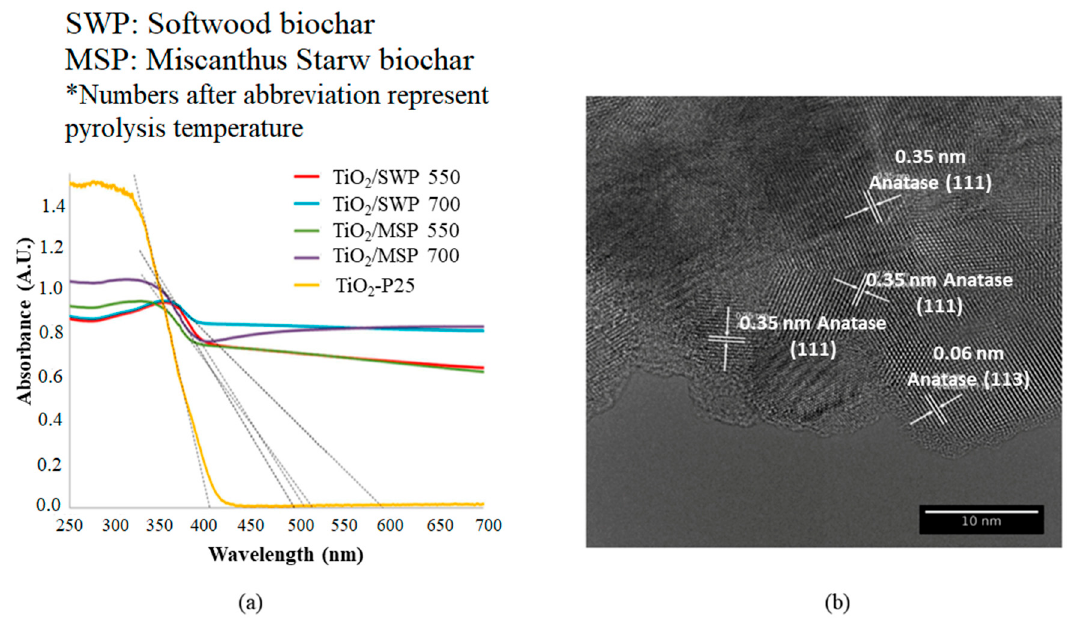
Figure 8. ( a ) UV-Visible absorbance of TiO 2 and biochar-supported TiO 2 (BSTPs) nanocomposites; ( b ) High-resolution transmission electron microscope image (HRTEM) of BSTPs (reproduced with permission from reference [78] copyright © 2021, American Chemical Society).